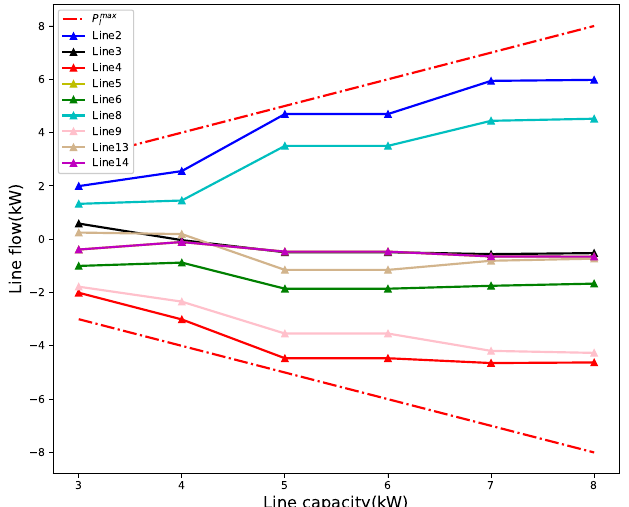
Figure 5. Convergence of the algorithm. Figure 4. Convergence of the algorithm.